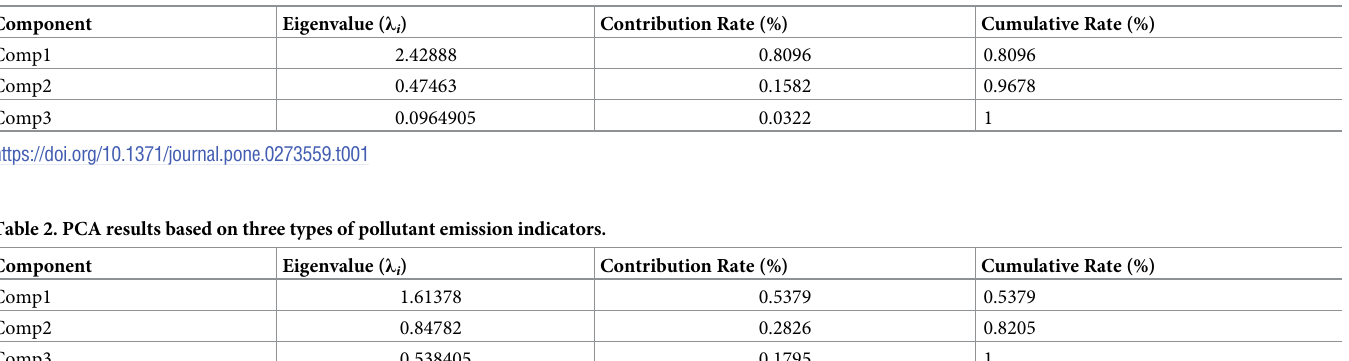
Table 1. PCA results based on three types of resource consumption indicators.